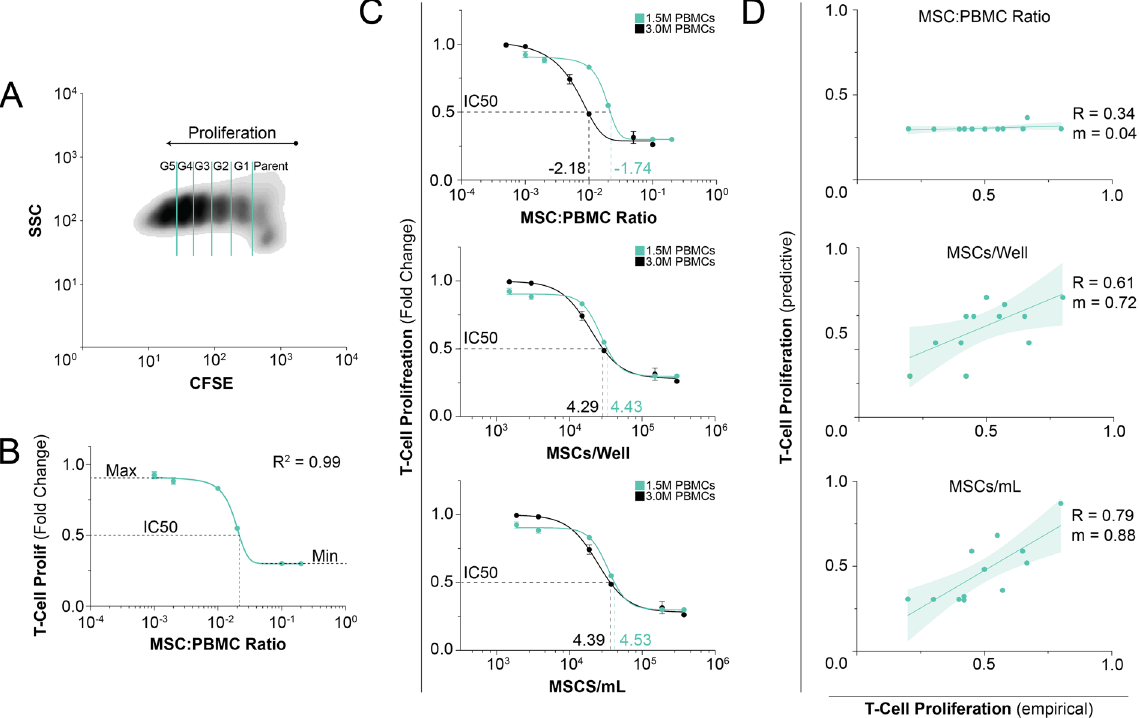
Figure 1. Pharmacological assessment of MSC immunosuppression with perturbation and regression analysis. PBMC proliferation was measured using flow cytometry and CFSE staining after stimulation with ConA and IL-2 for a period of 4 days. ( A ) Density plot of CFSE dilution; clear definition between proliferative generations (up to 5) is apparent. ( B ) Dose response curve of MSC suppression of T cell activation; data points represent mean + / − SD of 3 samples. Six ratios of MSCs were co-cultured with 1.5 M PBMCs to generate a full dose response curve (1:5, 1:10, 1:50, 1:100, 1:500, and 1:1000). This curve is fit by a pharmacologic dose response regression (Equation 2) with strong fit (R 2 = 0.99). ( C ) Independent variable assessment was performed by doubling the number of PBMCs; data points represent mean + / − SD of 3 samples. ( top ) Two distinct curves form using the metric of ratio showing poor universal applicably of this metric with a nearly 3-fold difference between IC50 values. ( middle & bottom ) Implementing a cells/well and cell/mL approach, we find greatly improved agreement between these curves with a IC50 value differences less than 1.5-fold. ( D ) Each independent variable was then assessed again several matched studies to determine broad applicability using correlative lines were generated using a linear